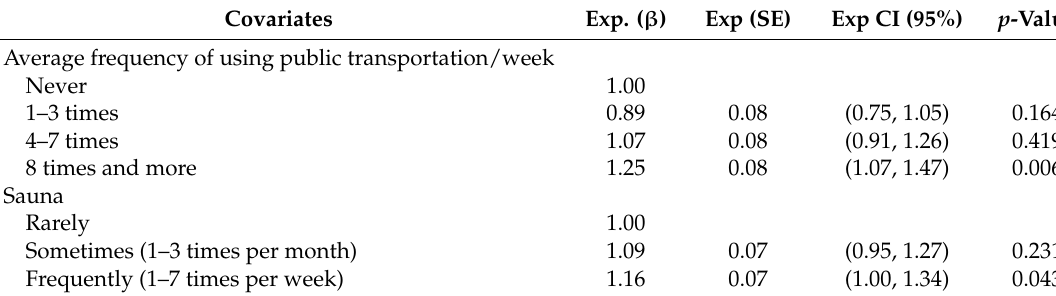
Public facility usage and socio-demographic factors related to log-urinary cotinine concentrations in generalized linear